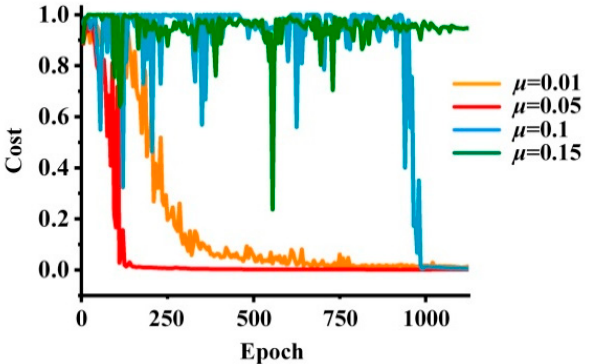
Figure 10. The convergence process of cost under different learning rates.